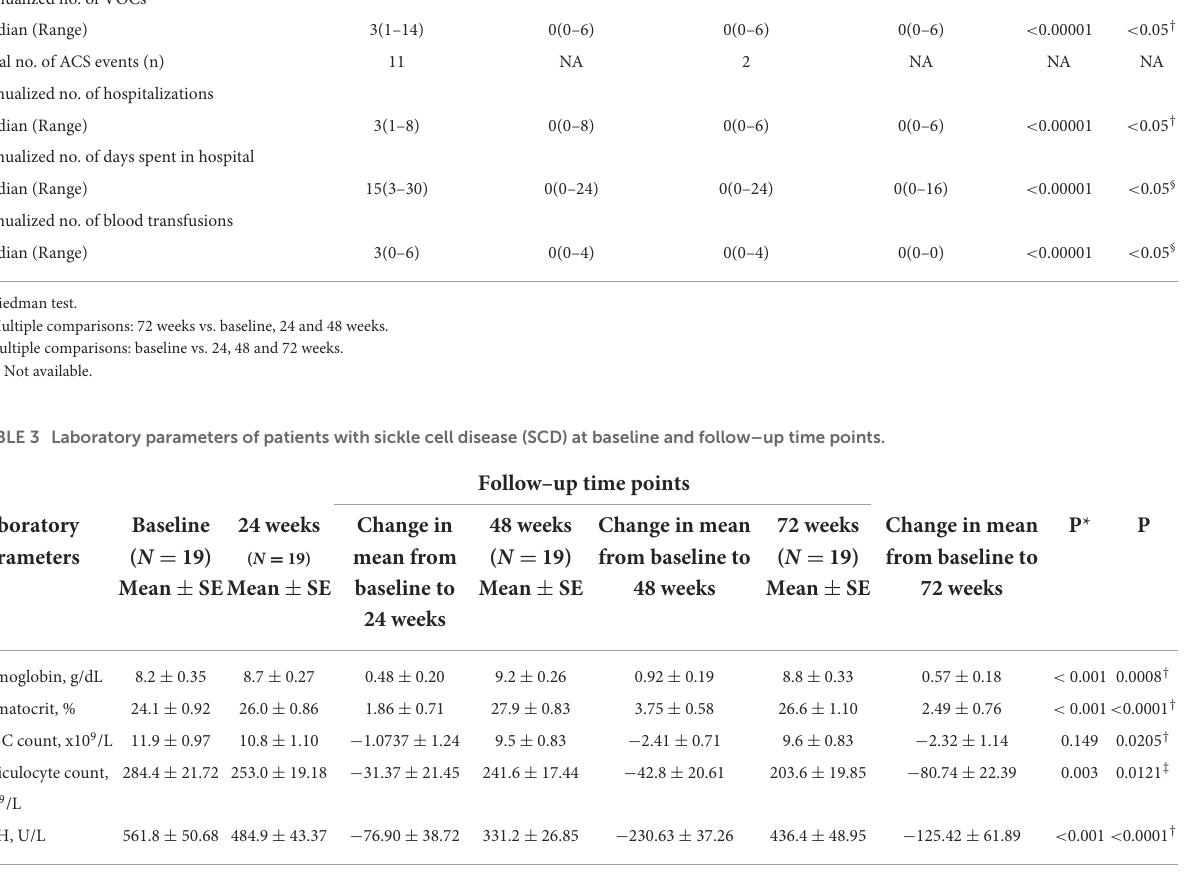
Follow–up time points